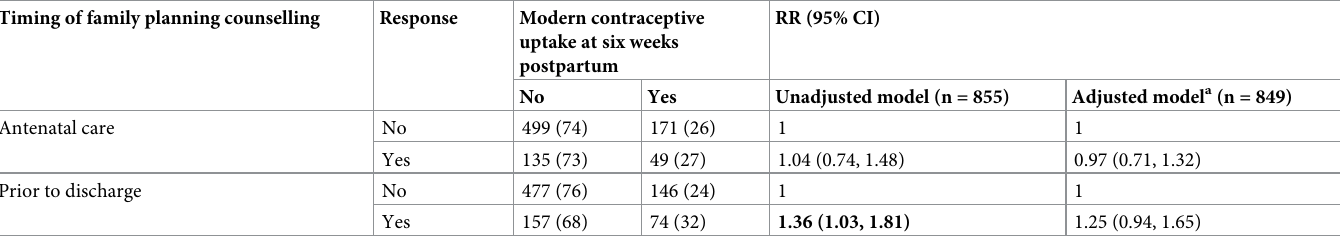
Table 3. Association between family planning counselling during the maternal health services and modern contraceptive uptake at six weeks postpartum. Timing of family planning